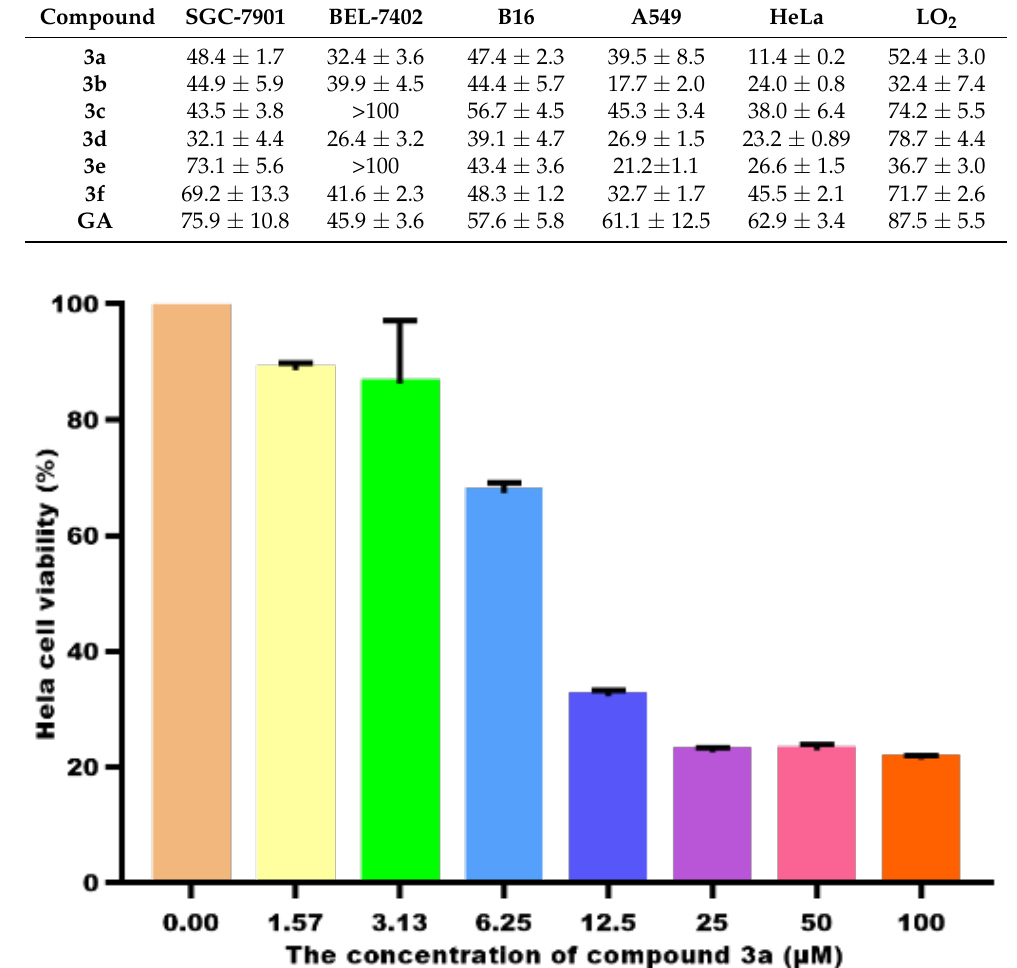
Figure 1. The cell viability of HeLa treated with different concentrations of 3a for 48 h. Table 1. IC 50 (μM) values of 3a – 3f toward the selected cancer cells for 48 h.